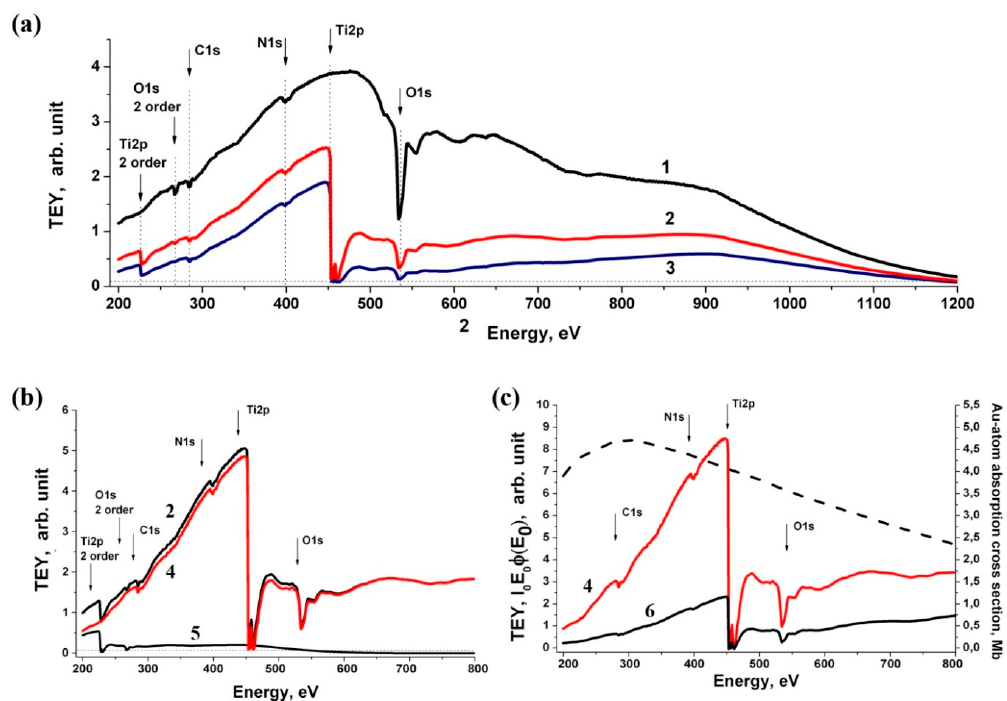
Figure 8. Total electron yield (TEY) signal and I 0 E 0 j ( E 0 ) spectral dependences of pure gold: ( a ) the TEY signal obtained from the surface of pure gold without a filter (1) and using Ti filters with a thickness of 150 nm (2) and 230 nm (3). Vertical lines show the Ti2p, O1s, and N1s absorption edges in the first and second orders of reflection from the di ff raction grating; dashed horizontal line is the level of the scattered long-wave background; ( b ) spectral dependences of the measured TEY signal (2), monochromatized TEY signal (4) and second-order radiation (5) on the pure gold surface using 150 nm Ti filter. The arrows indicate the absorption edges in the first and second di ff raction orders; ( c ) spectral dependences of the TEY monochromatic signal on the Au plate with a 150 nm Ti filter (4), I 0 E 0 j ( E 0 ) (6) and the absorption cross section of the gold atom [23] (dashed line) in Mb (right scale). Figure 8c shows the spectral dependence proportional to the incident radiation intensity I 0 E 0 φ Au ( E 0 ) in relative units, defined as the ratio of the received monochromatic TEY signal from the